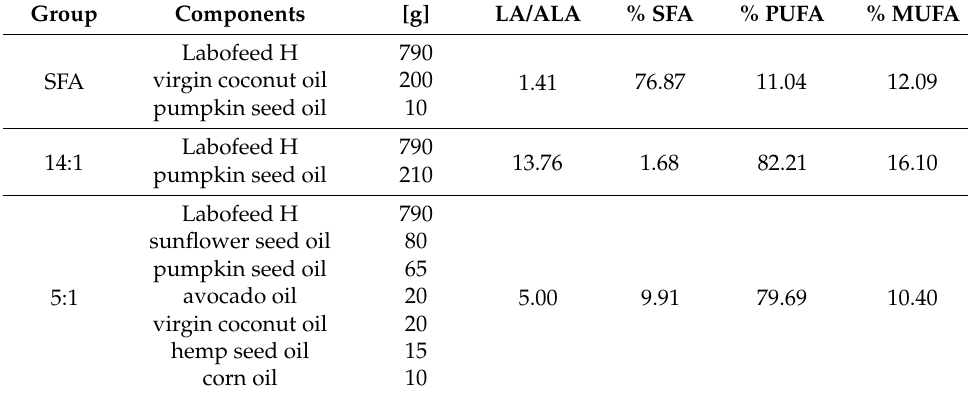
Table 1. Gas Chromatography